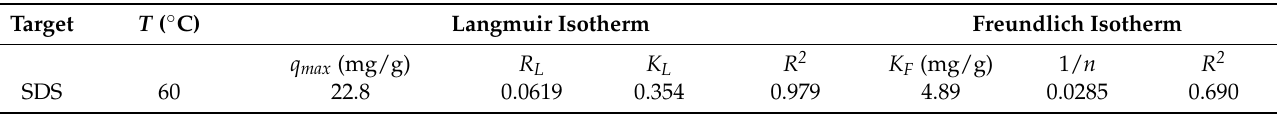
Table 3. Isotherm parameters for SDS adsorption by modified cellulose.